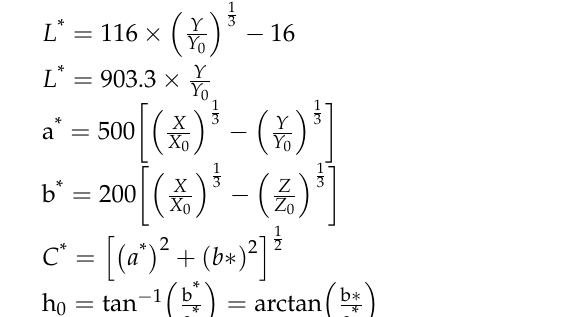
Figure 6. CIE Lab colour space.